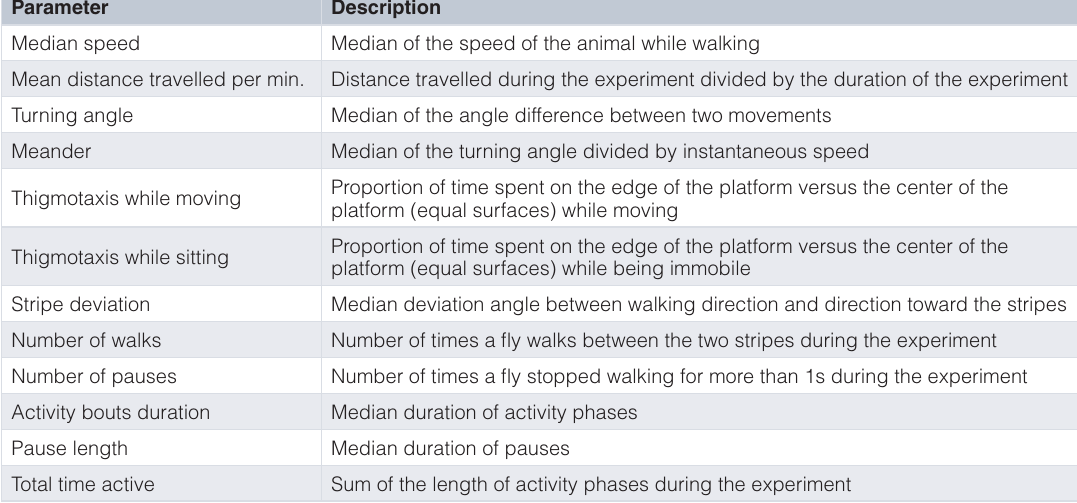
Table 1. Brief description of the twelve parameters calculated from the trajectory of the flies used in this paper. A more detailed description is available at http://dx.doi.org/10.6084/m9.figshare.844624. Parameter Description Median speed Median of the speed of the animal while walking Mean distance travelled per